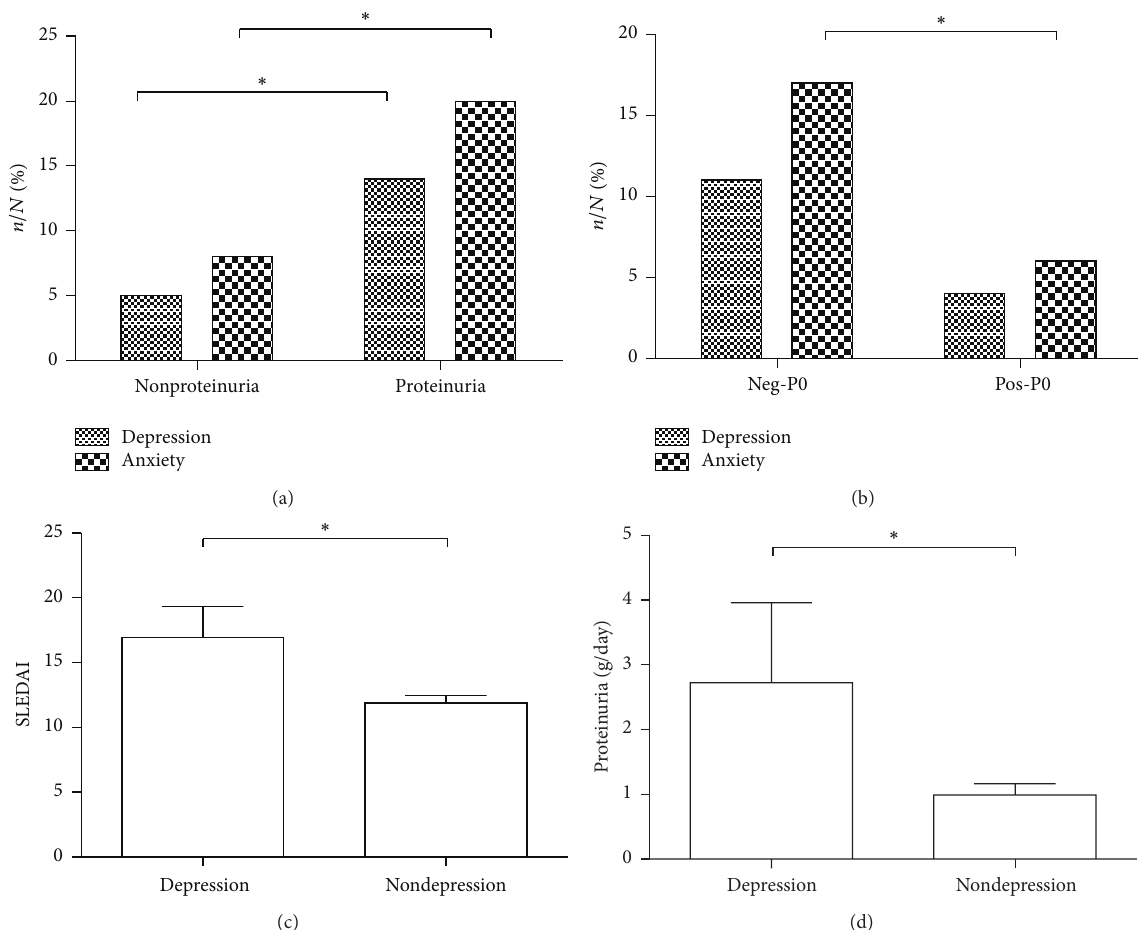
Figure 1: Association between emotional disorders and clinical phenotypes of SLE. (a) The prevalence of depression and anxiety was higher in patients with proteinuria; (b) the prevalence of anxiety was higher in patients with negative P0 antibody; (c) the SLEDAI score of depression patients was higher; (d) depression patients were with more proteinuria. ∗ showed 𝑝 < 0.05